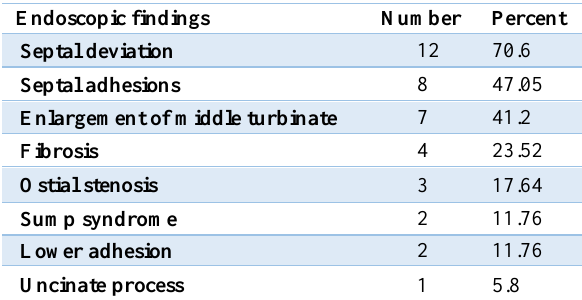
Table 2. Endoscopic Findings in the patients With